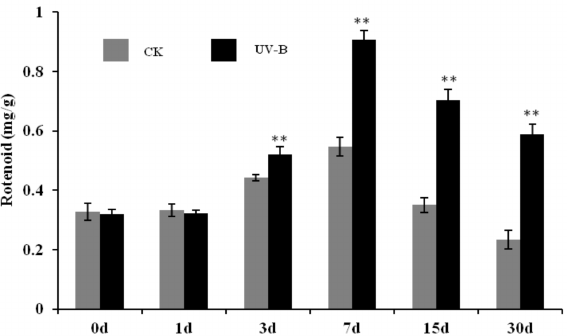
Figure 2. Analysis of rotenoid content in the roots of M. himalaica compared UV-B radiation with (CK). The “**” represented the significant difference level between treatments ( p -value <